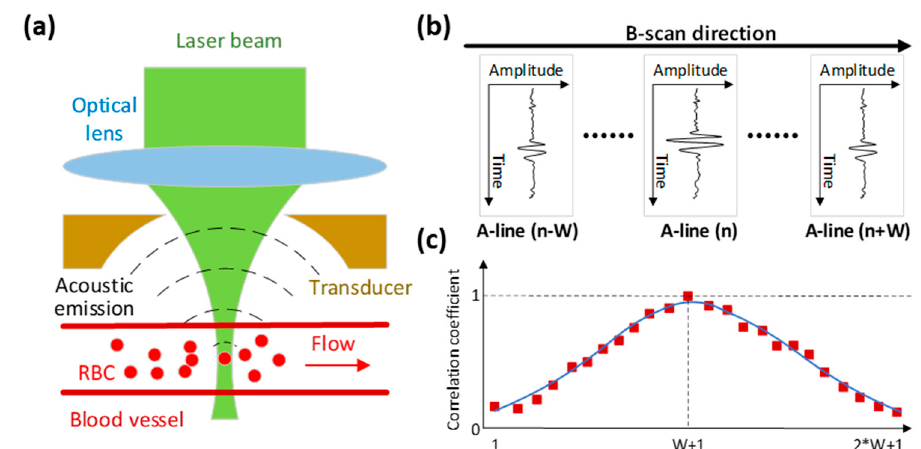
Figure 2. Blood flow measurement principle. ( a ) Experiment configuration. ( b ) Photoacoustic A-lines and B-scan. ( c ) Correlation analysis of the sequentially acquired A-line signals.